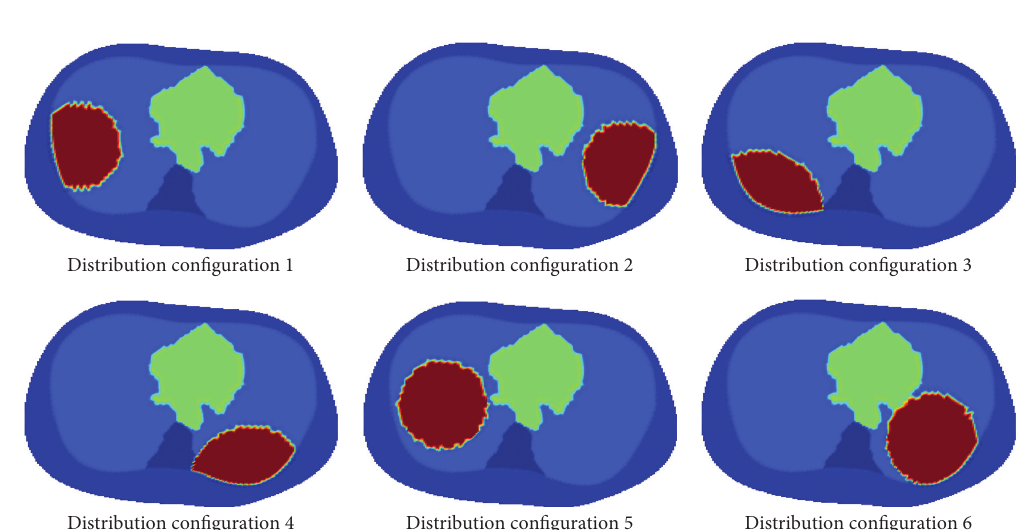
Figure 4: Configurations of the internal tissue and organ distribution of the FEM of the human